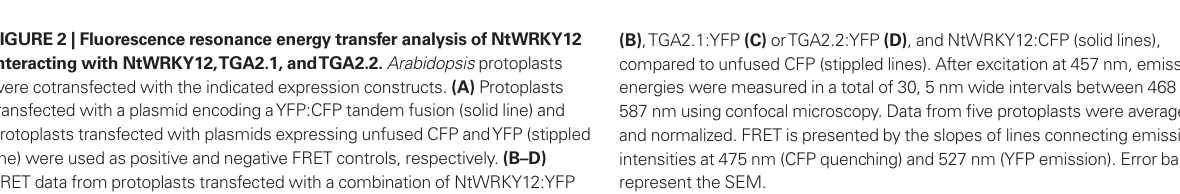
(B) , TGA2.1:YFP (C) or TGA2.2:YFP (D) , and NtWRKY12:CFP (solid lines), compared to unfused CFP (stippled lines). After excitation at 457 nm,